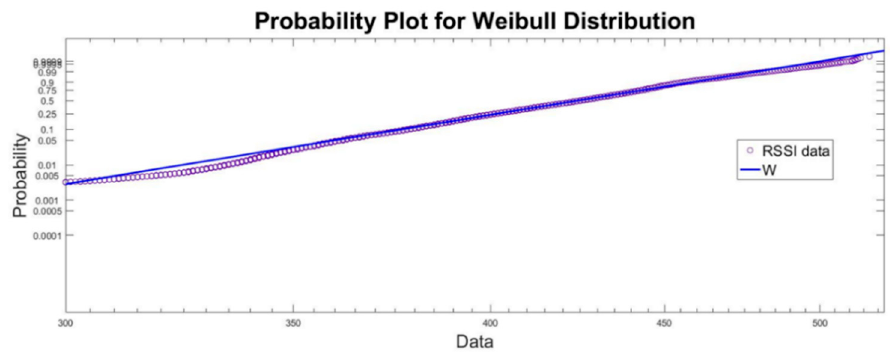
Figure 6. Probability plot for Weibull distribution against RSSI data.